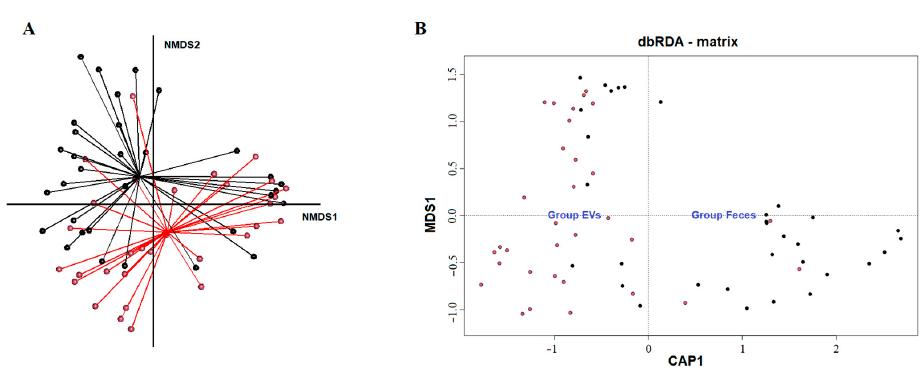
Figure 3. ( A ) Non-metric dimensional scaling model of the microbial profiles illustrating the matrix category of the samples (model with k = 5, stress = 0.094). Samples are represented as dots, with black = fecal microbiota sample and Red = fecal-microbe-derived EVs. Samples are connected to the centromere of each group with lines. ( B ) Distance-based redundancy analysis of the microbial profiles, taking into account the matrix (dbRDA). First dimension, CAP1, is the result of the constrained ordination of the samples based upon the matrix value. Following axes are non-constrained dimensions. Samples are represented as dots. Black= fecal microbiota sample and red = fecal-microbe-derived EVs. Matrix centromeres are represented as group labels in blue.